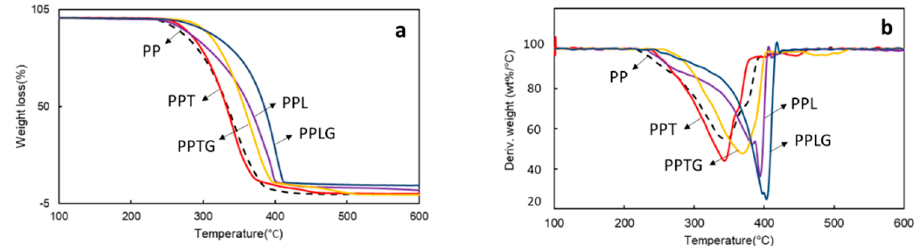
Figure 5. Thermal behaviors of PP, PP/polyphenol blends, and PP/crosslinked polyphenol blends: ( a ) TGA curves; ( b ) DTG curves.